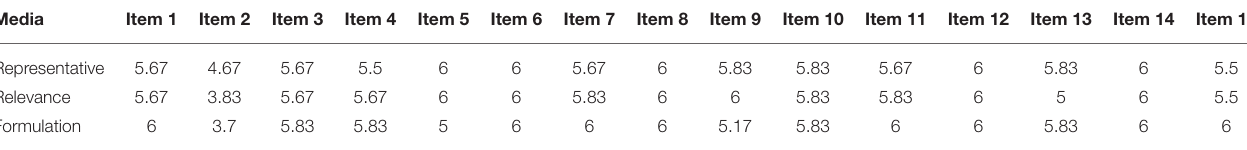
TABLE 8 | Mean (teachers-post). Media